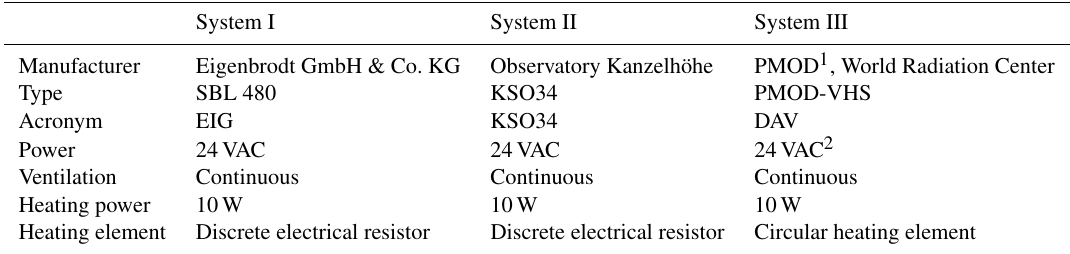
Table 1. Characteristics of the different heating and ventilation systems used in this